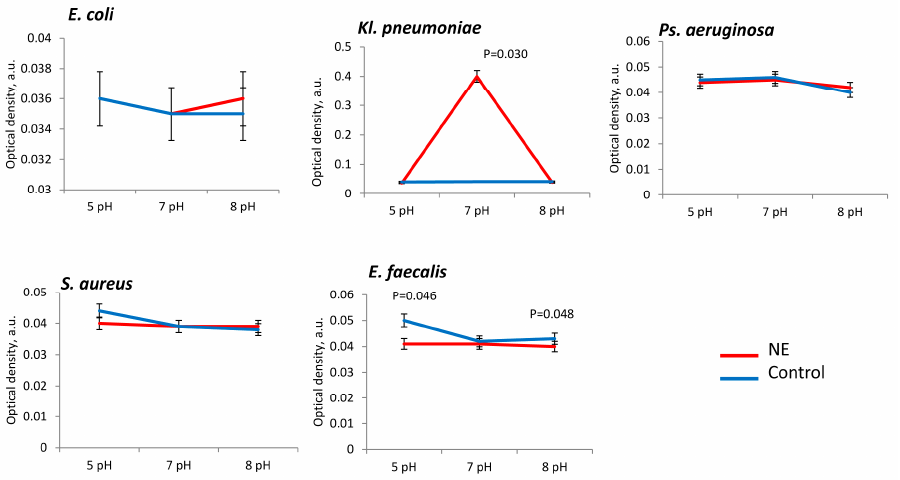
Figure 3. Matrix production of uropathogenic microorganisms is influenced by pH and the presence of NE in PBS.